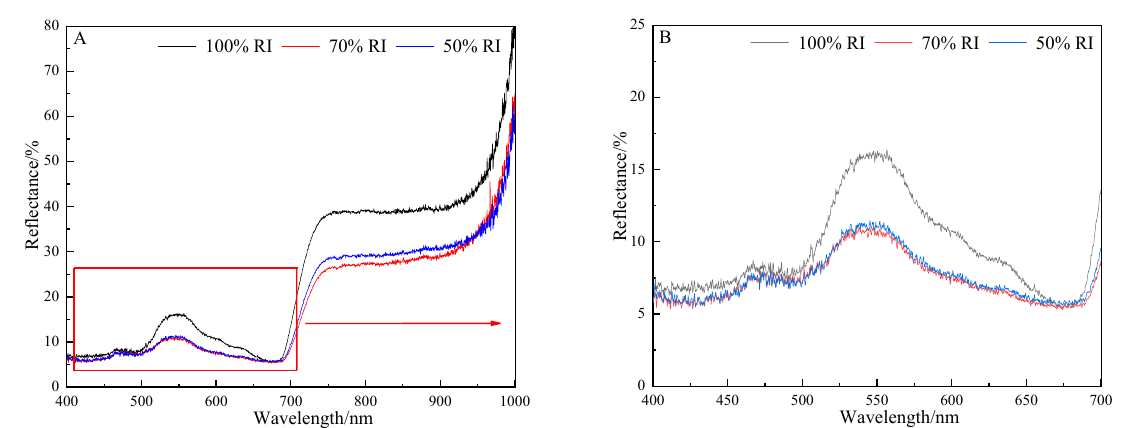
The values represent the percentage of different light wavelength range of natural light from 400 to 800 nm ( µ mol · m − 2 · s − 1 · nm − 1 ). Abbreviations: RI, relative irradiance. Follow the spectral described method of Riikonen et al. [71].